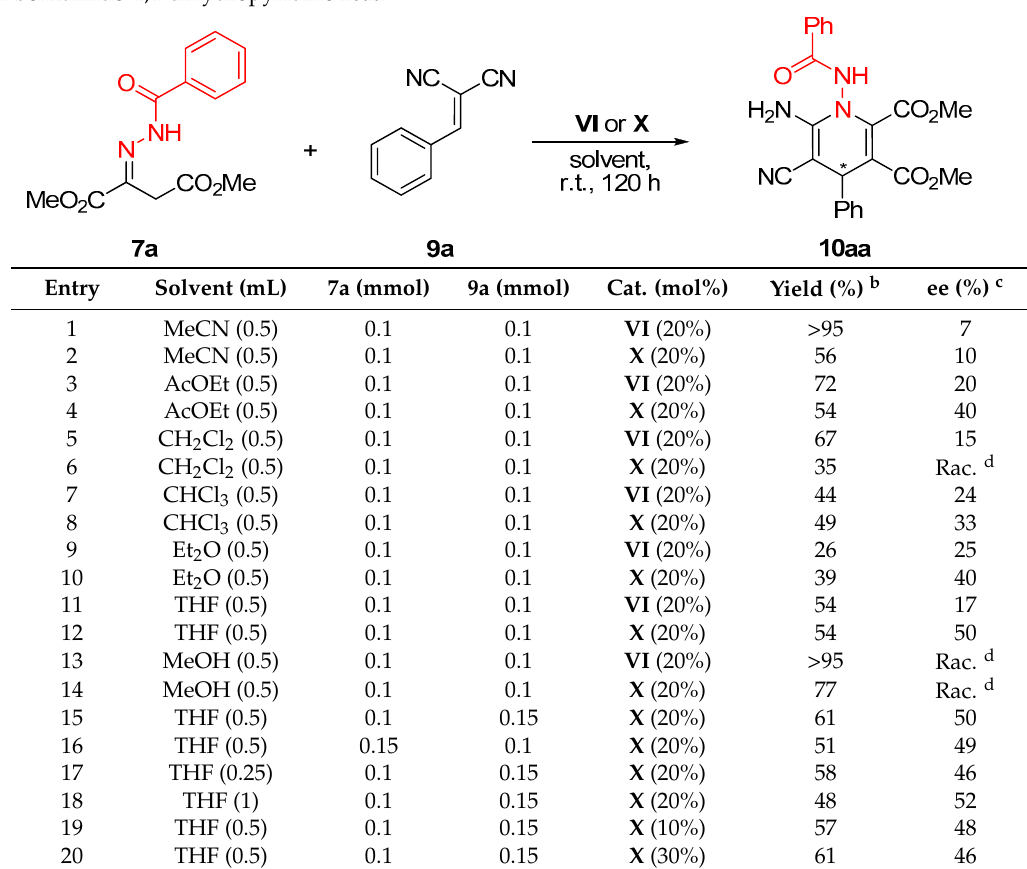
1. Screening of the reaction conditions for the synthesis of chiral 1-benzamido-1,4-dihydropyridine 10aa a .